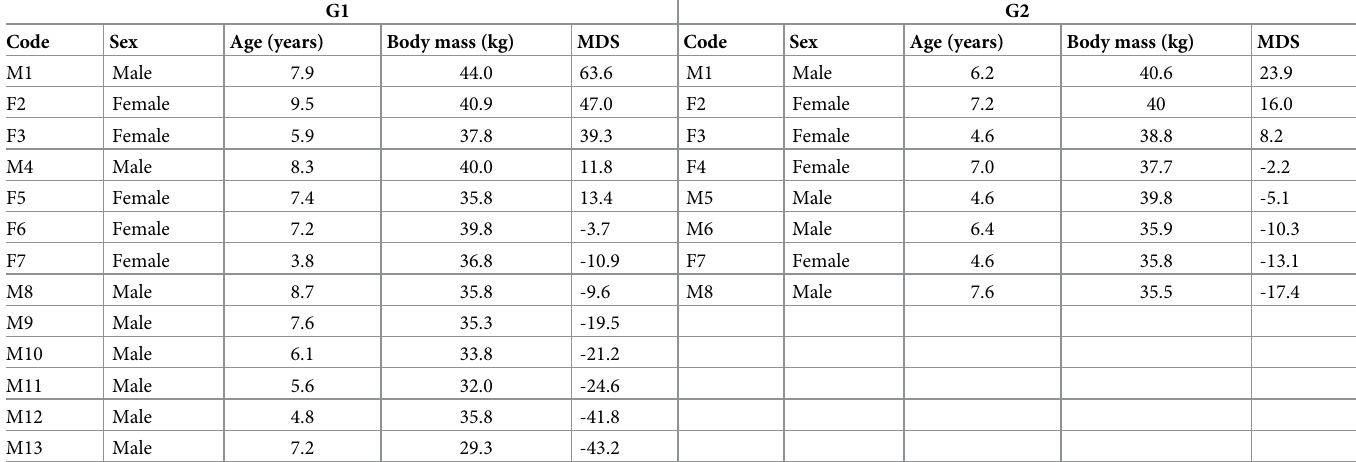
Table 1. Sex, age, body mass and social rank (modified dominance David’s scores–MDS) of the individuals of two captive white-lipped peccary groups (G1: N = 13; G2: N = 8). G1